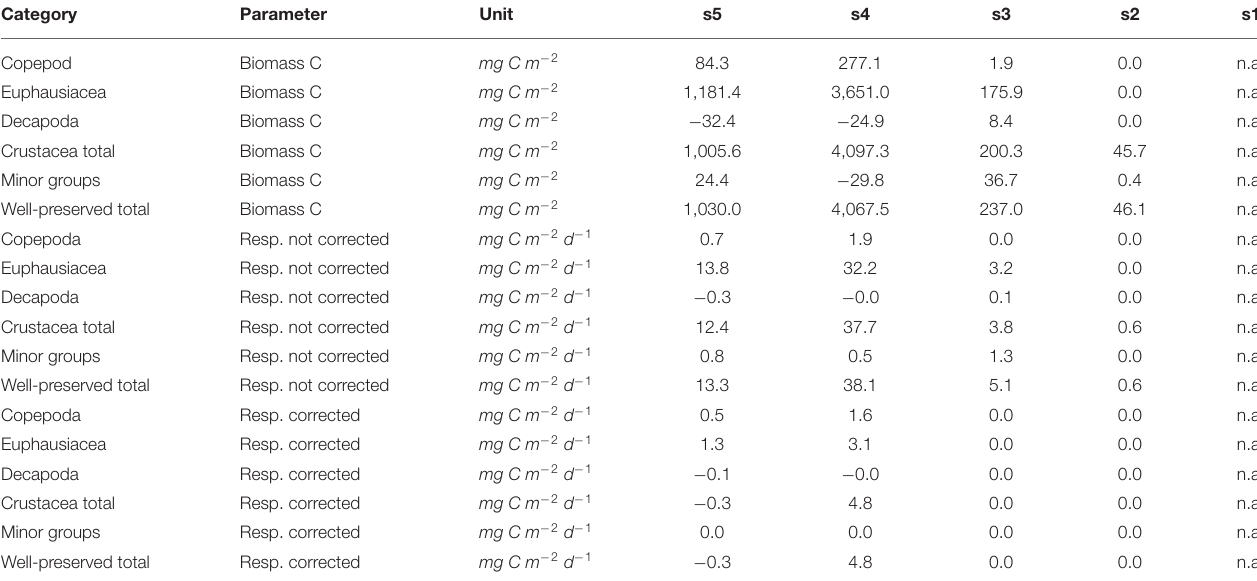
TABLE 4 | Integrated day-night differences below the 100m depth